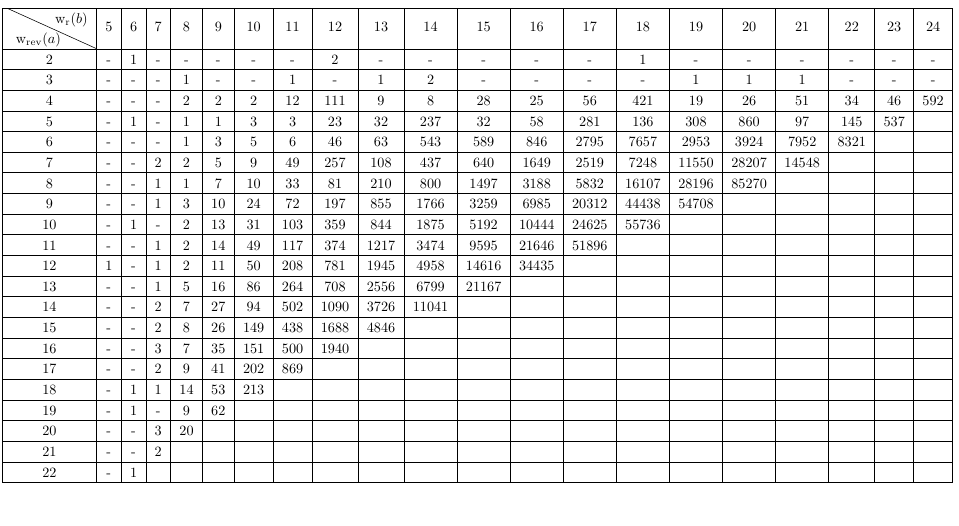
Table 2: Weight distribution table of canonical 2-round trail cores in Subterranean up to weight 28.